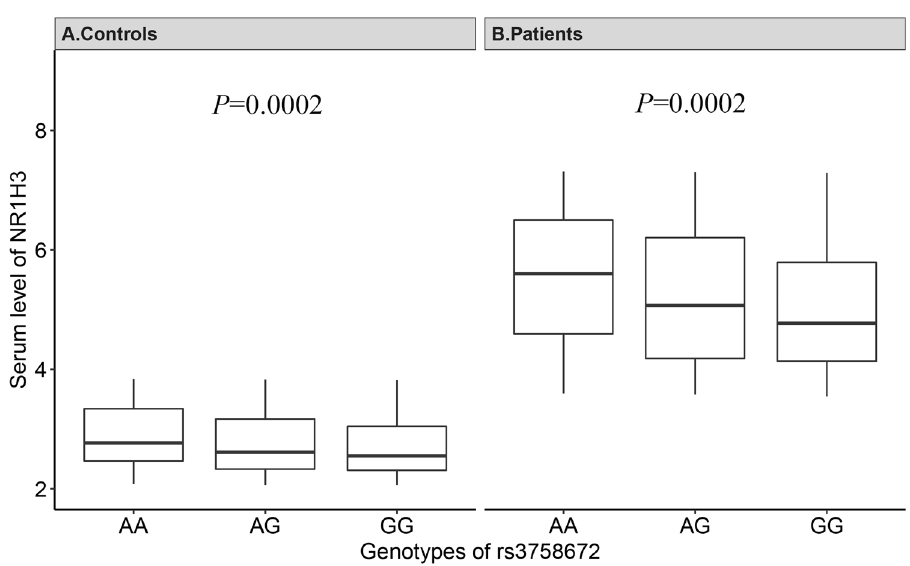
Figure 2. Serum levels of NR1H3 for participants with different genotypes of SNP rs3758672. ( A ) Controls, ( B ) patients with NSV. Kruskal–Wallis (K-W) tests were